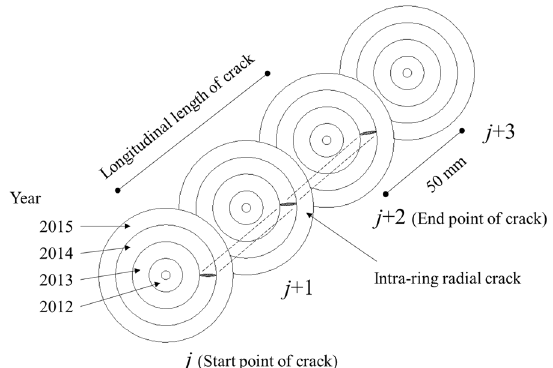
Fig. 3 Outline of intra-ring radial crack